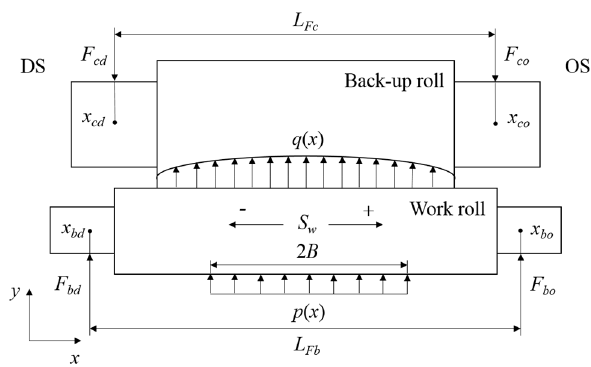
Figure 3. Simplified mechanical model of the upper rolls.